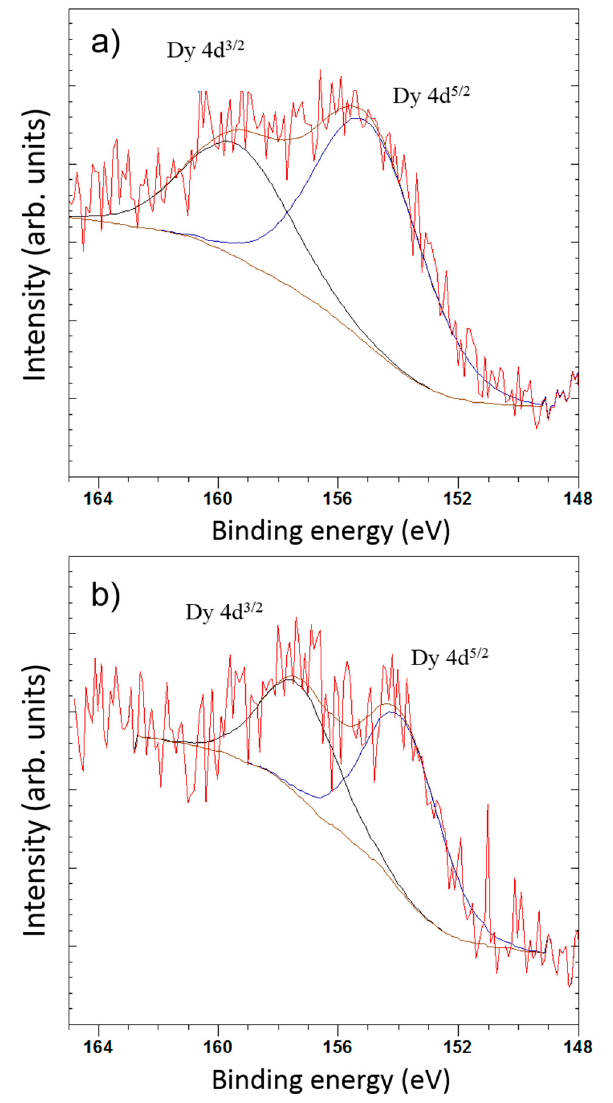
Figure 9. X-ray photoelectron spectroscopy (XPS) deconvolution spectra of Dy 4d peak of ( a ) AC-PA:Dy and ( b ) AC-CA:Dy.